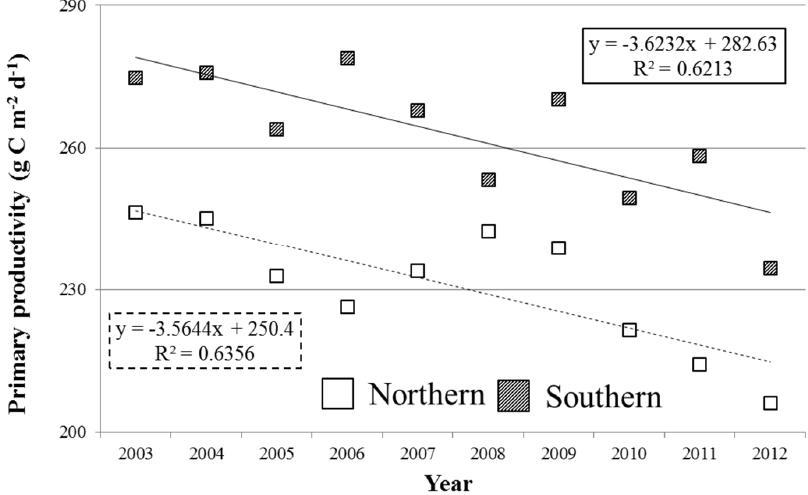
Figure 7. Long-term patterns of annual primary productions for the southern and northern areas in the East Sea from 2003 to 2012. Dashed and solid lines represent decadal trends in annual primary productions in the southern and northern areas, respectively.